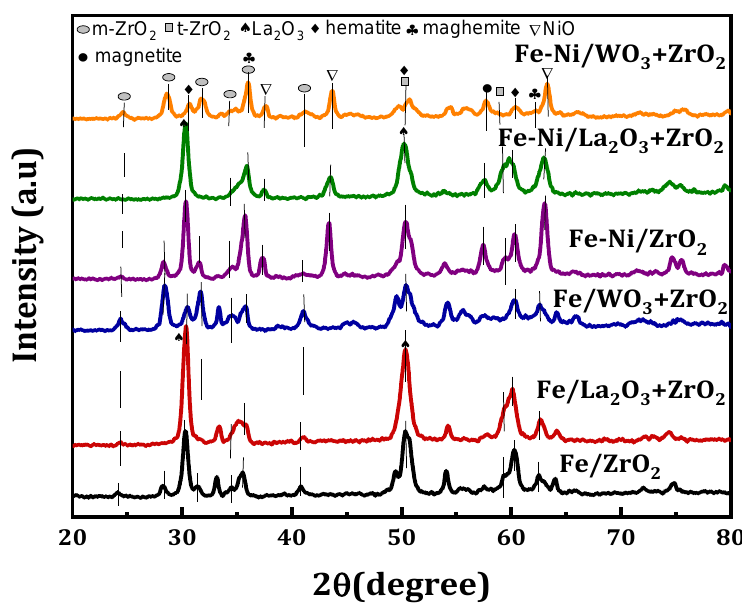
Figure 1. XRD profiles for the Fe / x-ZrO 2 - and Fe-Ni / x-ZrO 2 -supported (x = 0, La 2 O 3 , WO 3 ) catalysts.